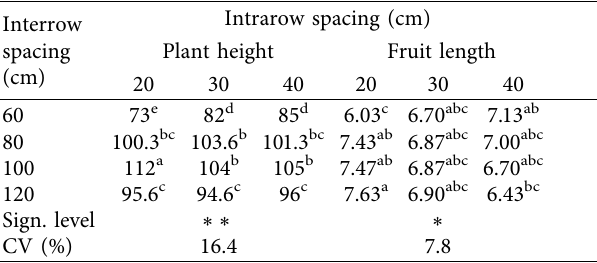
Table 2: Interaction effect of inter- and intrarow spacing on plant height and fruit length of